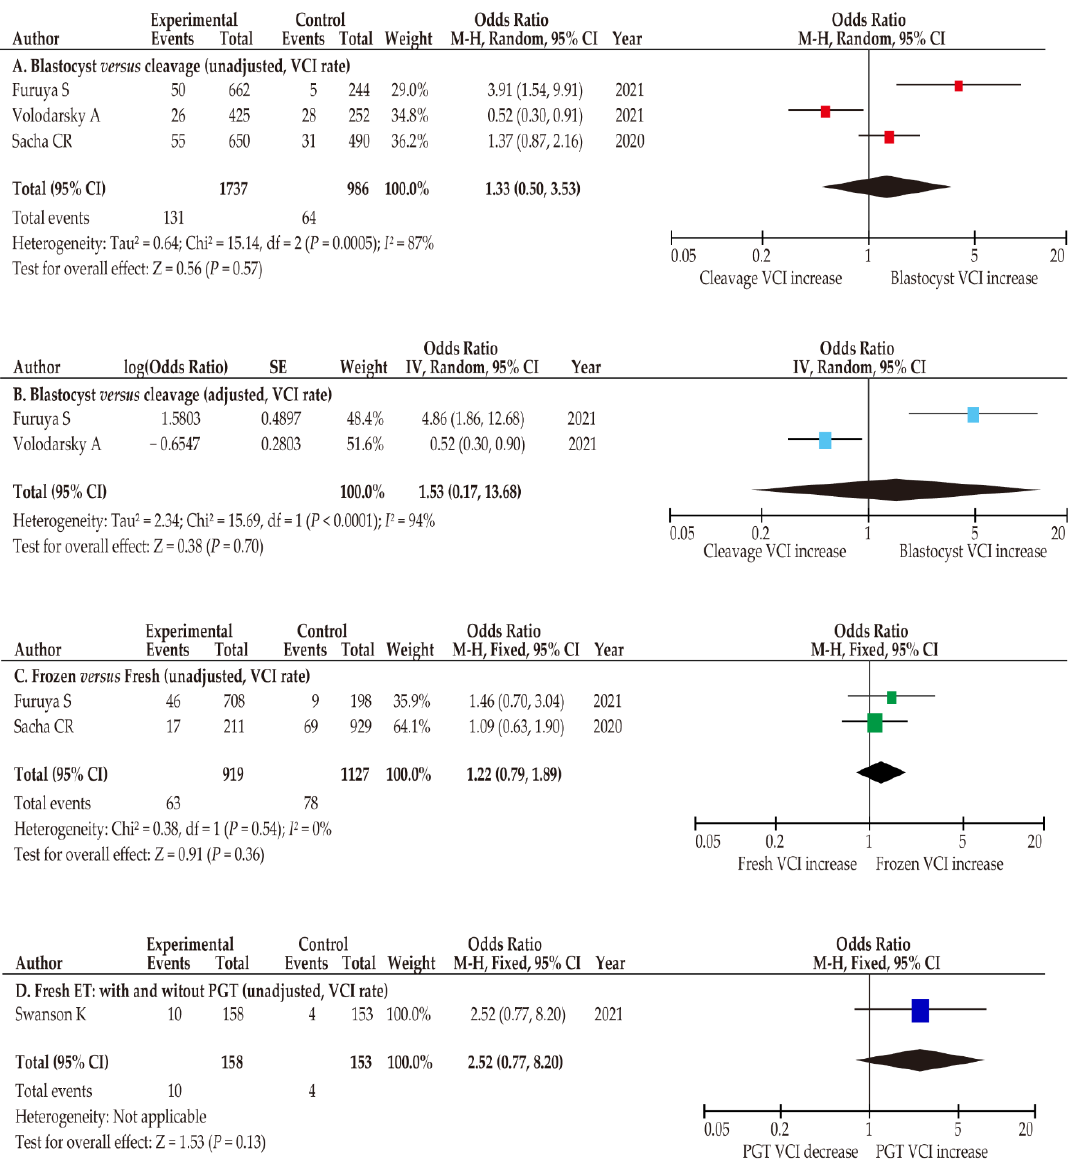
Figure 3. Risk of VCI according to ART type. Pooled odds ratios (ORs) were calculated using RevMan version 5.4.1 (Cochrane Collaboration, Copenhagen, Denmark). Thus, some values may be slightly different from their original state. The following comparisons were performed to determine VCI risk: ( A, B ) blastocyst transfer versus cleavage stage transfer ( A , unadjusted; B , adjusted),, ( C ) frozen ET versus fresh ET, and ( D ) frozen ET with versus without PGT. Forest plots were arranged according to the year of publication. Substantial heterogeneity was observed in the analysis of A and B (A, I 2 = 87%; B, I 2 = 94%), whereas no heterogeneity was observed in analysis of C (C, I 2 = 0%). Abbreviations: VCI, velamentous cord insertion; ART, assisted reproductive technology; blastocyst, blastocyst transfer; cleavage stage transfer; frozen ET, frozen embryo transfer; fresh ET, fresh em- bryo transfer; PGT, preimplantation genetic testing; OR, odds ratio; CI, confidence interval; SE, standard error. 3.4.2. Frozen ET Versus Fresh ET The rate of VCI between frozen ET versus fresh ET was compared between two stud- ies (Table 2) [25,28]. The rate of VCI was similar between frozen ET and fresh ET in both the unadjusted ( n = 2; OR 1.22, 95%CI 0.79 – 1.89; heterogeneity, p = 0.36; I 2 = 0%) and ad- justed analyses ( n = 1; OR 1.58, 95%CI 0.79 – 3.55).